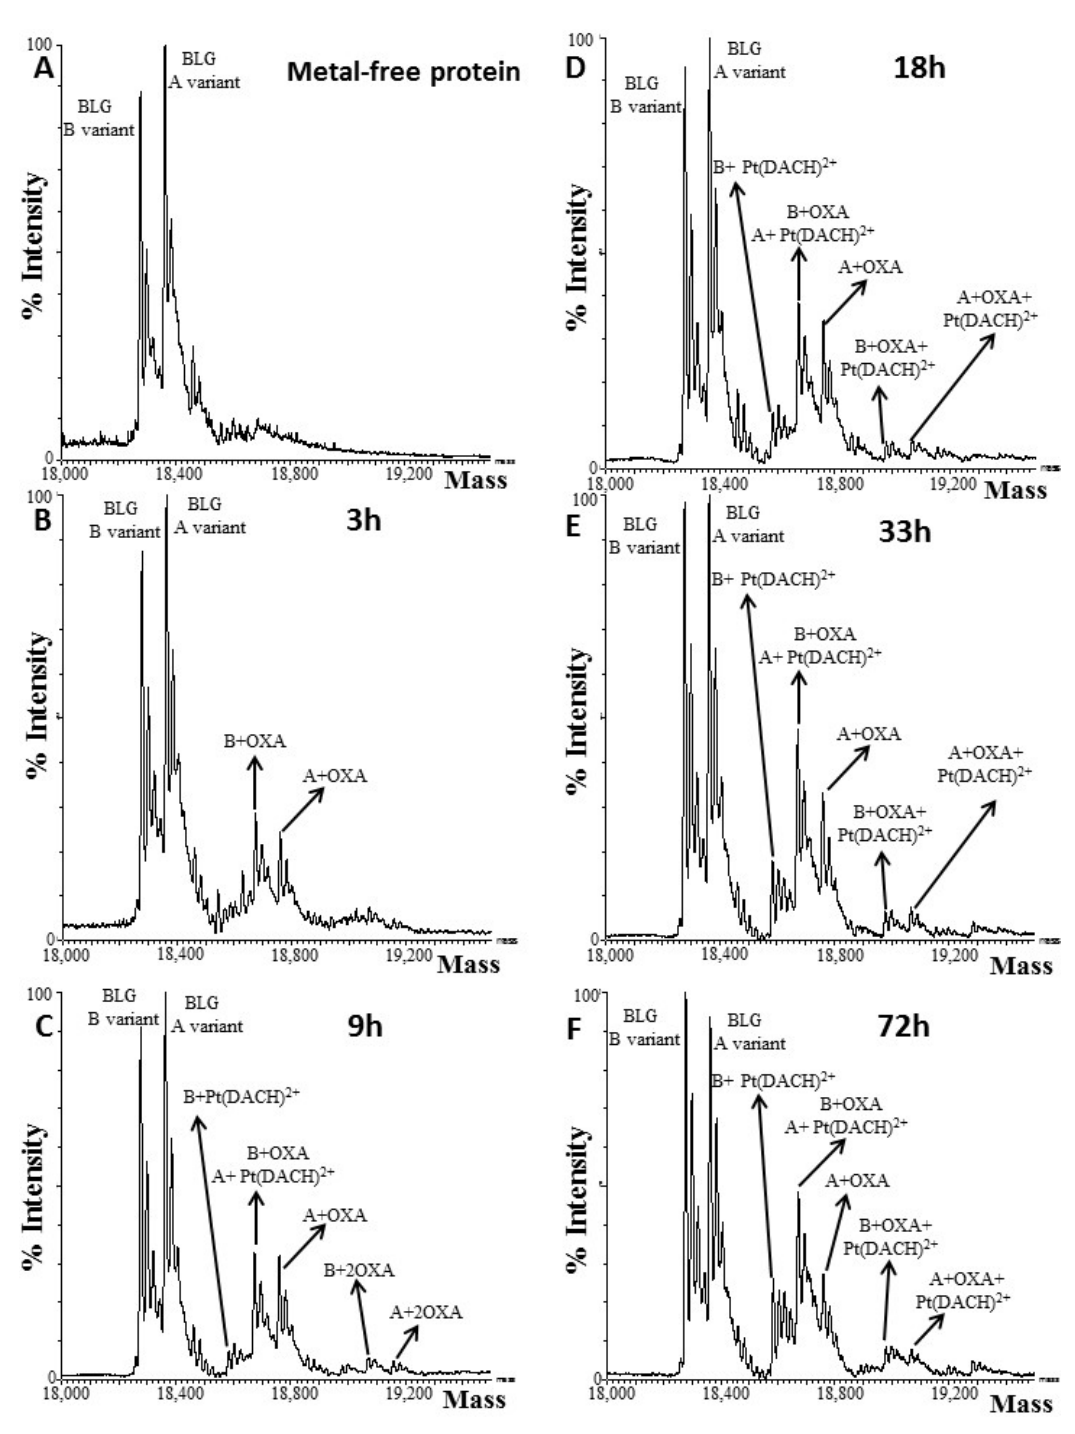
Figure 3. Deconvoluted ESI-MS spectra of free β-lactoglobulin (t = 0, panel A ) and following 3 h ( B ), 9 h ( C ), 18 h ( D ), 33 h ( E ) and 72 h ( F ) of incubation with OXA. A = A variant, B = B variant.